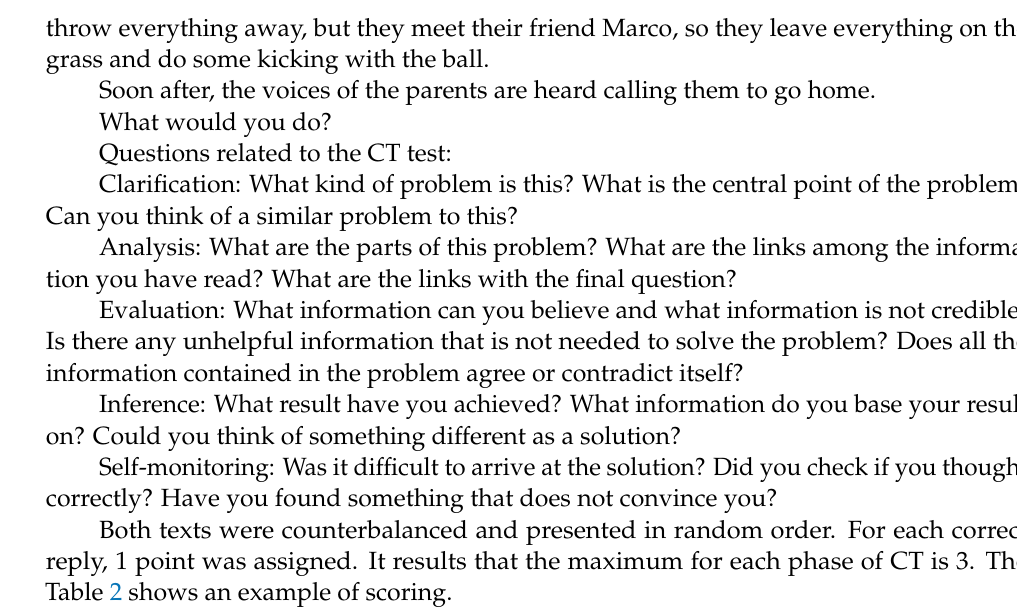
Table 2. Example of scoring for each question of the neutral